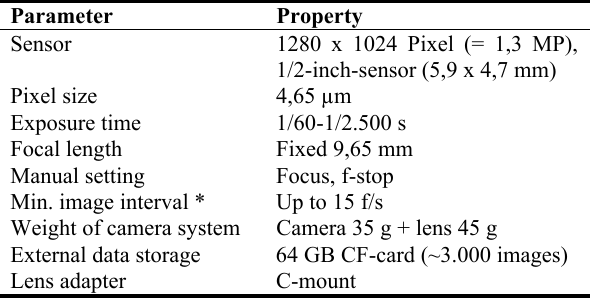
Table 1: Technical data of the Crevis MV-CS27U Parameter